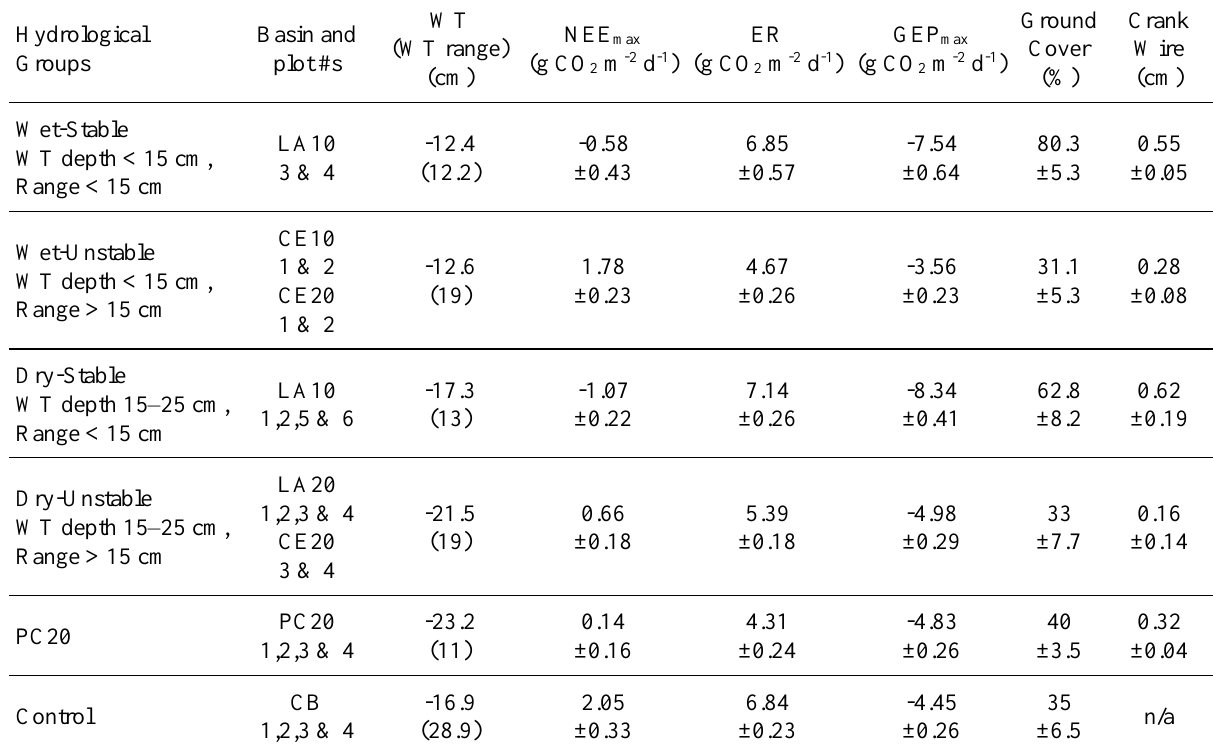
Table 1. Year 2 mean (± SE) field data, sorted by hydrological group, which is based on mean WT position (Wet = shallower than -15 cm, Dry = between -15 and -25 cm) and WT range (Stable = range less than 15 cm, Unstable = range greater than 15 cm). Basin and plot #s column indicates the number of plots in each hydrological group.